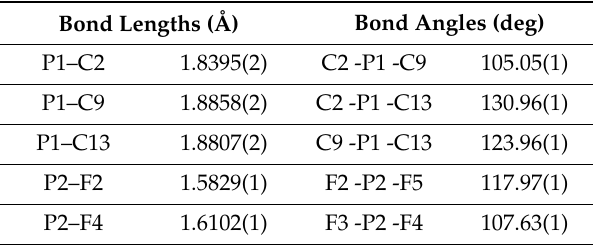
Figure 1. ORTEP diagram of complex 1 with thermal ellipsoids drawn at the 50% probability level. Table 1. Selected bond parameters of complex 1.